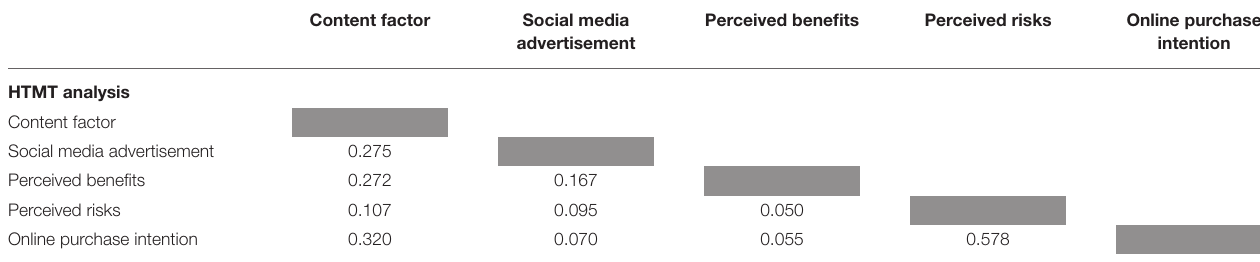
TABLE 4 | HTMT analysis to measure discriminant validity.